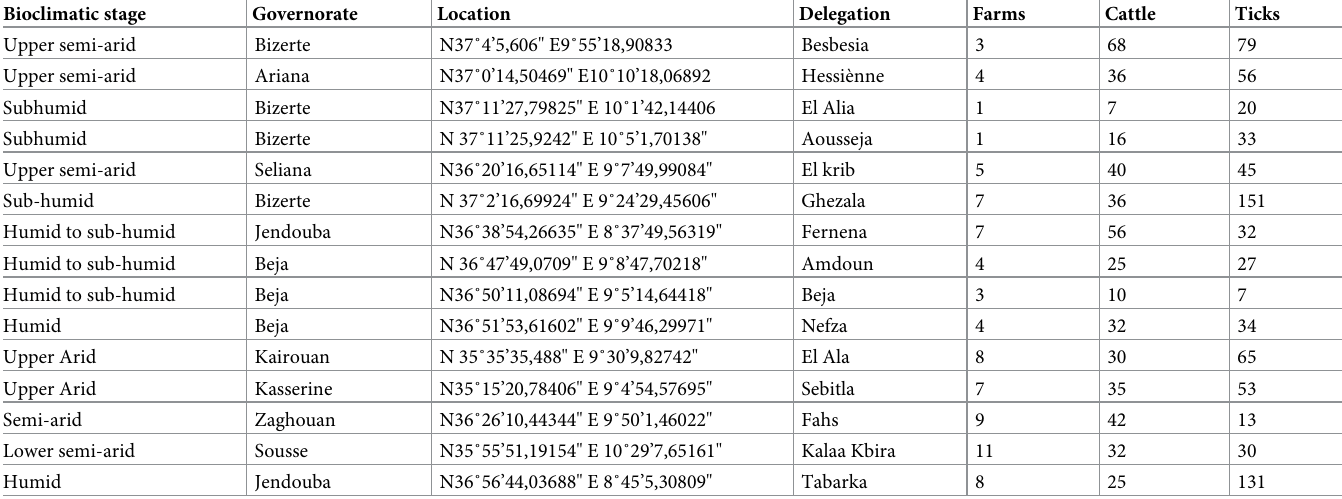
Table 1. Bioclimatic stage, governorate, location, delegation, farms visited, surveyed cattle and ticks collected. Bioclimatic